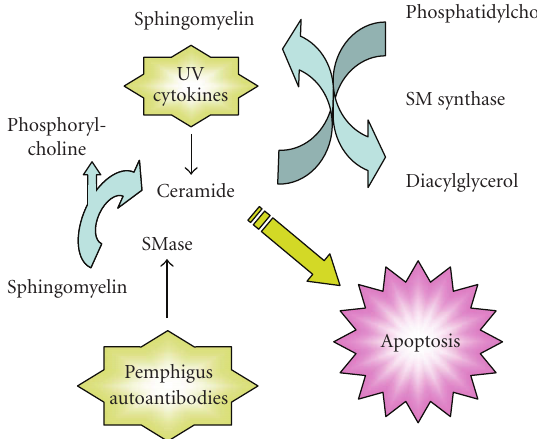
Figure 3: Hypothesized Involvement of Sphingolipid Metabolism in the Keratinocyte Response to Pemphigus Autoantibodies. Our hypothesis is that pemphigus autoantibodies binding to Dsgs results in the activation of sphingomyelinase (SMase) to produce ceramide and phosphorylcholine. In an attempt to survive, keratinocytes activate sphingomyelin synthase (SM synthase). The result is an increase in phosphorylcholine and diacylglycerol levels and a reduction in phosphatidylcholine. Stimuli that overwhelm the ability of the cell to metabolize ceramide, such as cytokines or ultraviolet (UV) light (or senescence), which increase ceramide levels, are proposed to allow manifestation of pathologic skin lesions. Note that UV light increases ceramide in at least two ways: first, by activation of both SMase-mediated [35] and de novo ceramide production [19] and second, by decreasing ceramidase activity/expression [60]. Ceramidases are key in the response of keratinocytes to UV light because (1) they metabolize ceramide and decrease its levels and (2) they generate sphingosine, which can be converted to S1P (which allows cell survival) by the action of sphingosine kinase. Indeed, knocking down sphingosine kinase sensitizes keratinocytes to UV-induced apoptosis [60]. In addition, ceramide and its metabolites can activate cytosolic phospholipase A2 and cyclooxygenase-2, suggesting that eicosanoids might be elevated and potentially contribute to the pemphigus disease process (reviewed in